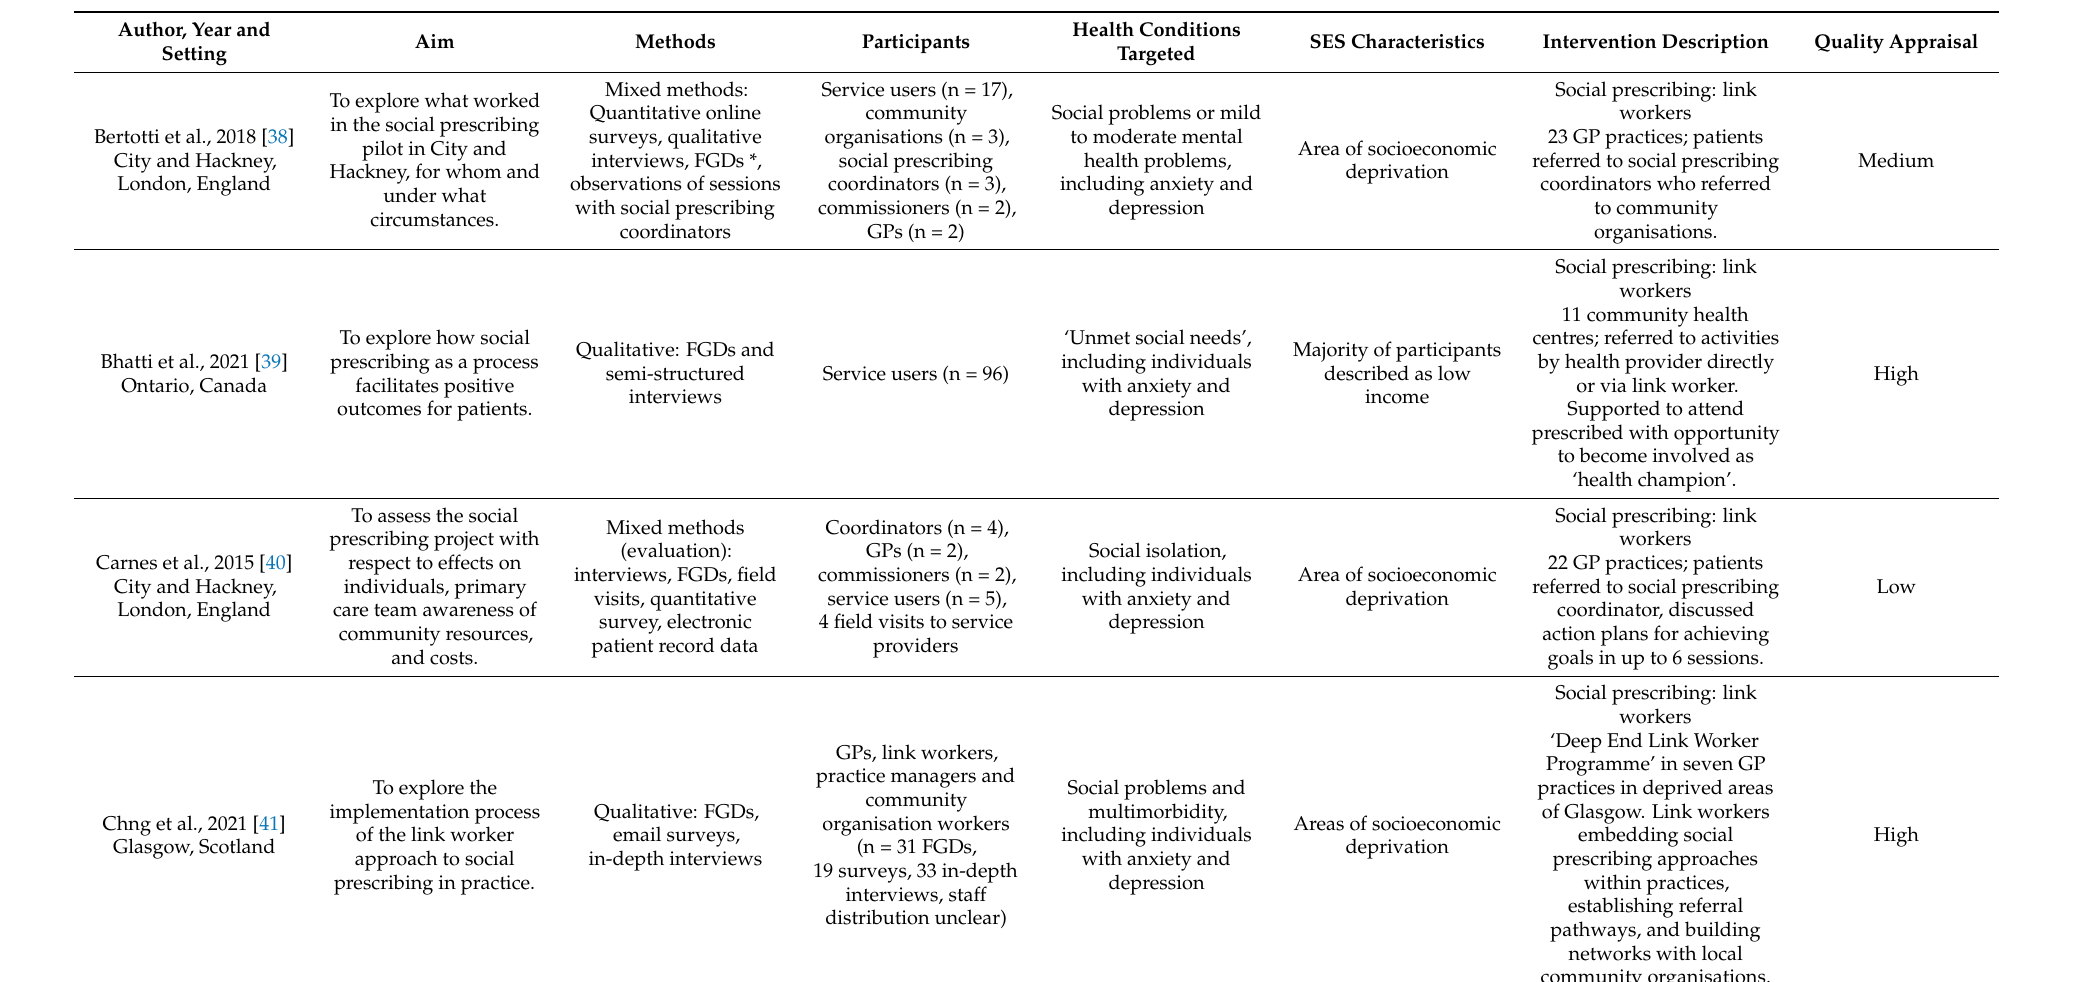
Table 2. Characteristics of included studies (* FGD = Focus Group